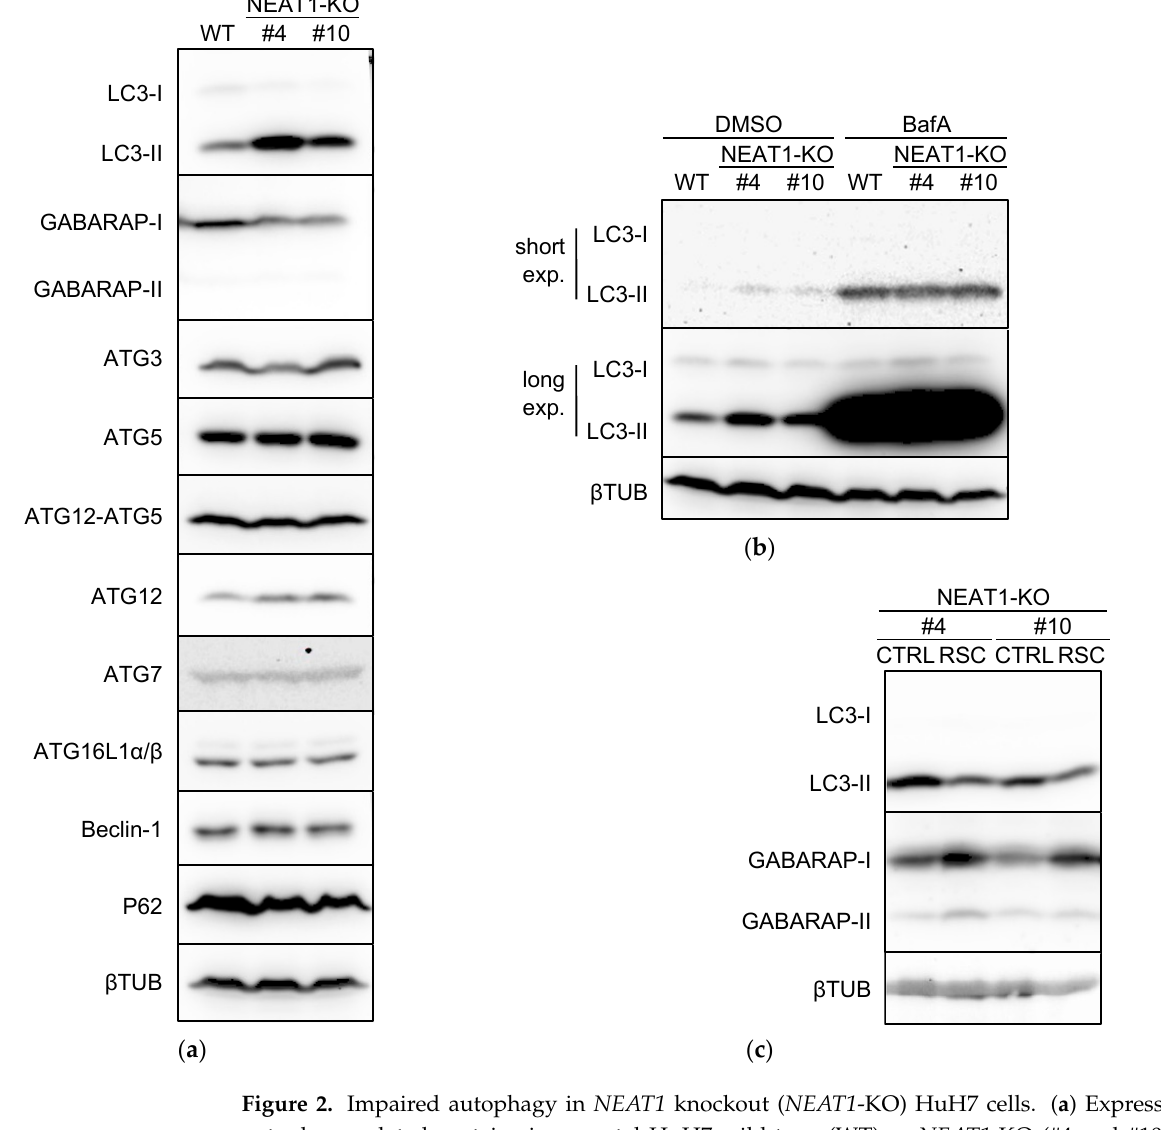
Figure 2. Impaired autophagy in NEAT1 knockout ( NEAT1 ‐ KO) HuH7 cells. ( a ) Expression of autophagy ‐ related proteins in parental HuH7 wild ‐ type (WT) or NEAT1 ‐ KO (#4 and #10) cells. ( b ) LC3 protein expression (upper; short exposure; lower; long exposure) in NEAT1 ‐ KO cells treated with dimethyl sulfoxide (DMSO) or 50 nM bafilomycin A1 (BafA) for 24 h. ( c ) LC3 and GABARAP expression in NEAT1 ‐ KO (CTRL) and rescued (RSC) cells. The internal control was β TUB. As NEAT1 is required for the maintenance of CSCs in HCC cell lines [10], the constitutive lack of this lncRNA might cause unexpected phenotypic changes. Thus, we investigated the effects of NEAT1 deficiency on autophagy by performing transient knockdown of NEAT1 . As shown in Figures 3a,b and S2F, NEAT1 knockdown decreased the expression levels of GABARAP in HLF and HuH6 cells at both mRNA and protein levels. A reporter assay measuring the activity of the GABARAP promoter indicated that NEAT1v1 induced GABARAP expression by activating its promoter (Figure S3), while the intracellular stability of GABARAP protein was not affected by NEAT1v1 (Figure S4), suggesting that NEAT1v1 regulates GABARAP expression at the transcriptional level. Moreover, NEAT1 knockdown significantly increased LC3 ‐ II expression level and the number of LC3 puncta (Figures 3b–d and S2F). These results suggest that NEAT1 is involved in maintaining the autophagy flux in HCC cells under nonirradiated conditions.